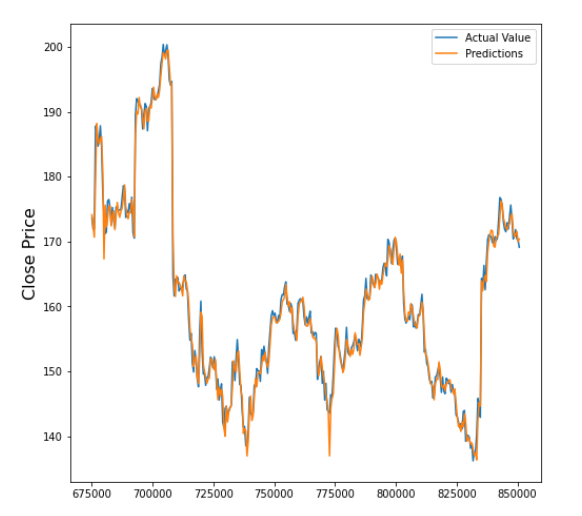
Figure 5. Prediction of Close price using Linear Regression Artificial Neural Networks